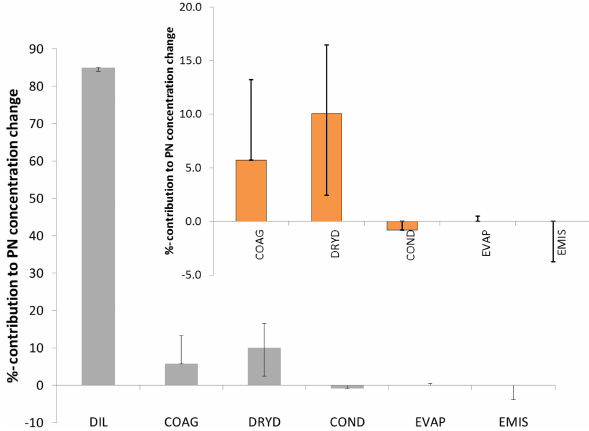
Figure 6. Contribution of processes to the percentage change of PN concentrations between roadside station and neighborhood environ- ment, and their associated uncertainty depicted as error bars. Inset magnifies the contribution and uncertainty of the aerosol processes and additional emissions of